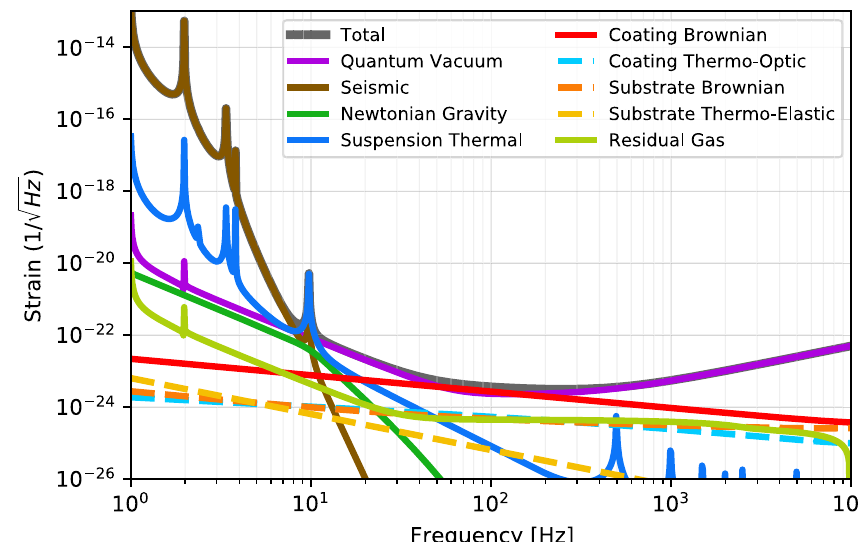
Fig. 1 Noise budget of Advanced LIGO showing its major noise sources. This plot was reproduced by pygwinc [https:// git. ligo. org/ gwinc/ pygwi nc]